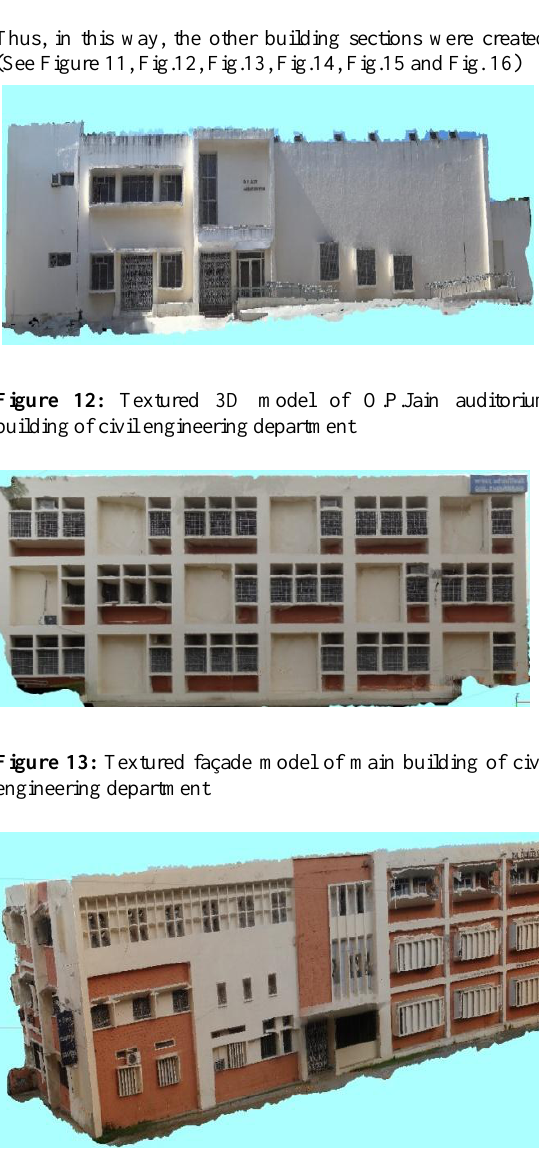
Figure 14: Textured 3D model of transportation section